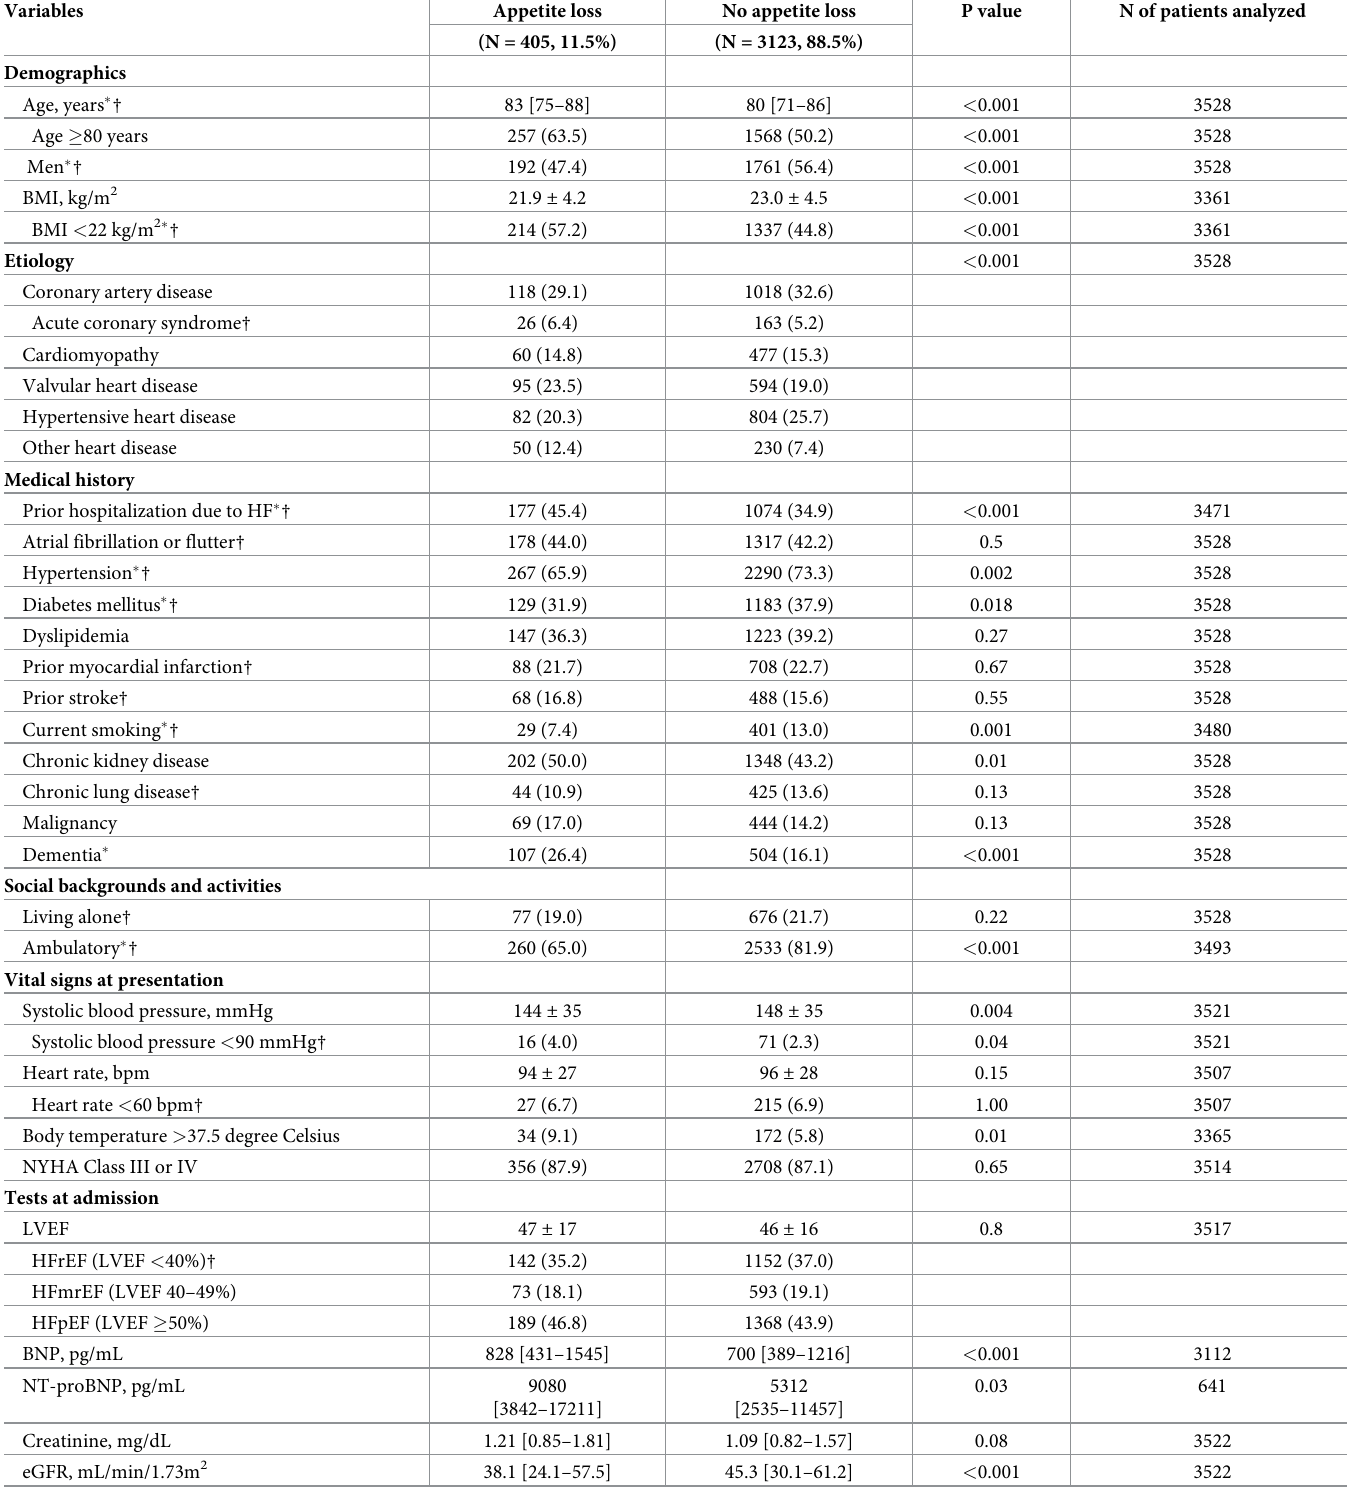
Table 1. Baseline patient